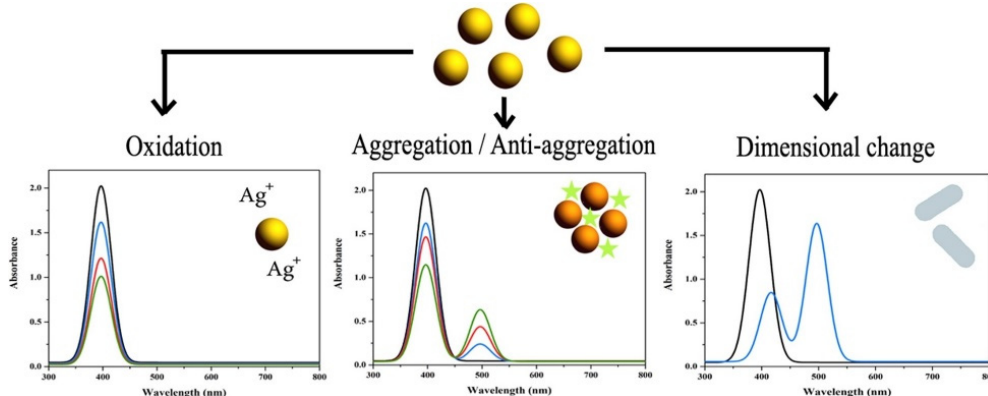
Figure 9. Sensing mechanisms of gold nanoparticle-based plasmonic sensors. Republished with permission from [95]; permission conveyed through Copyright Clearance Center, Inc.